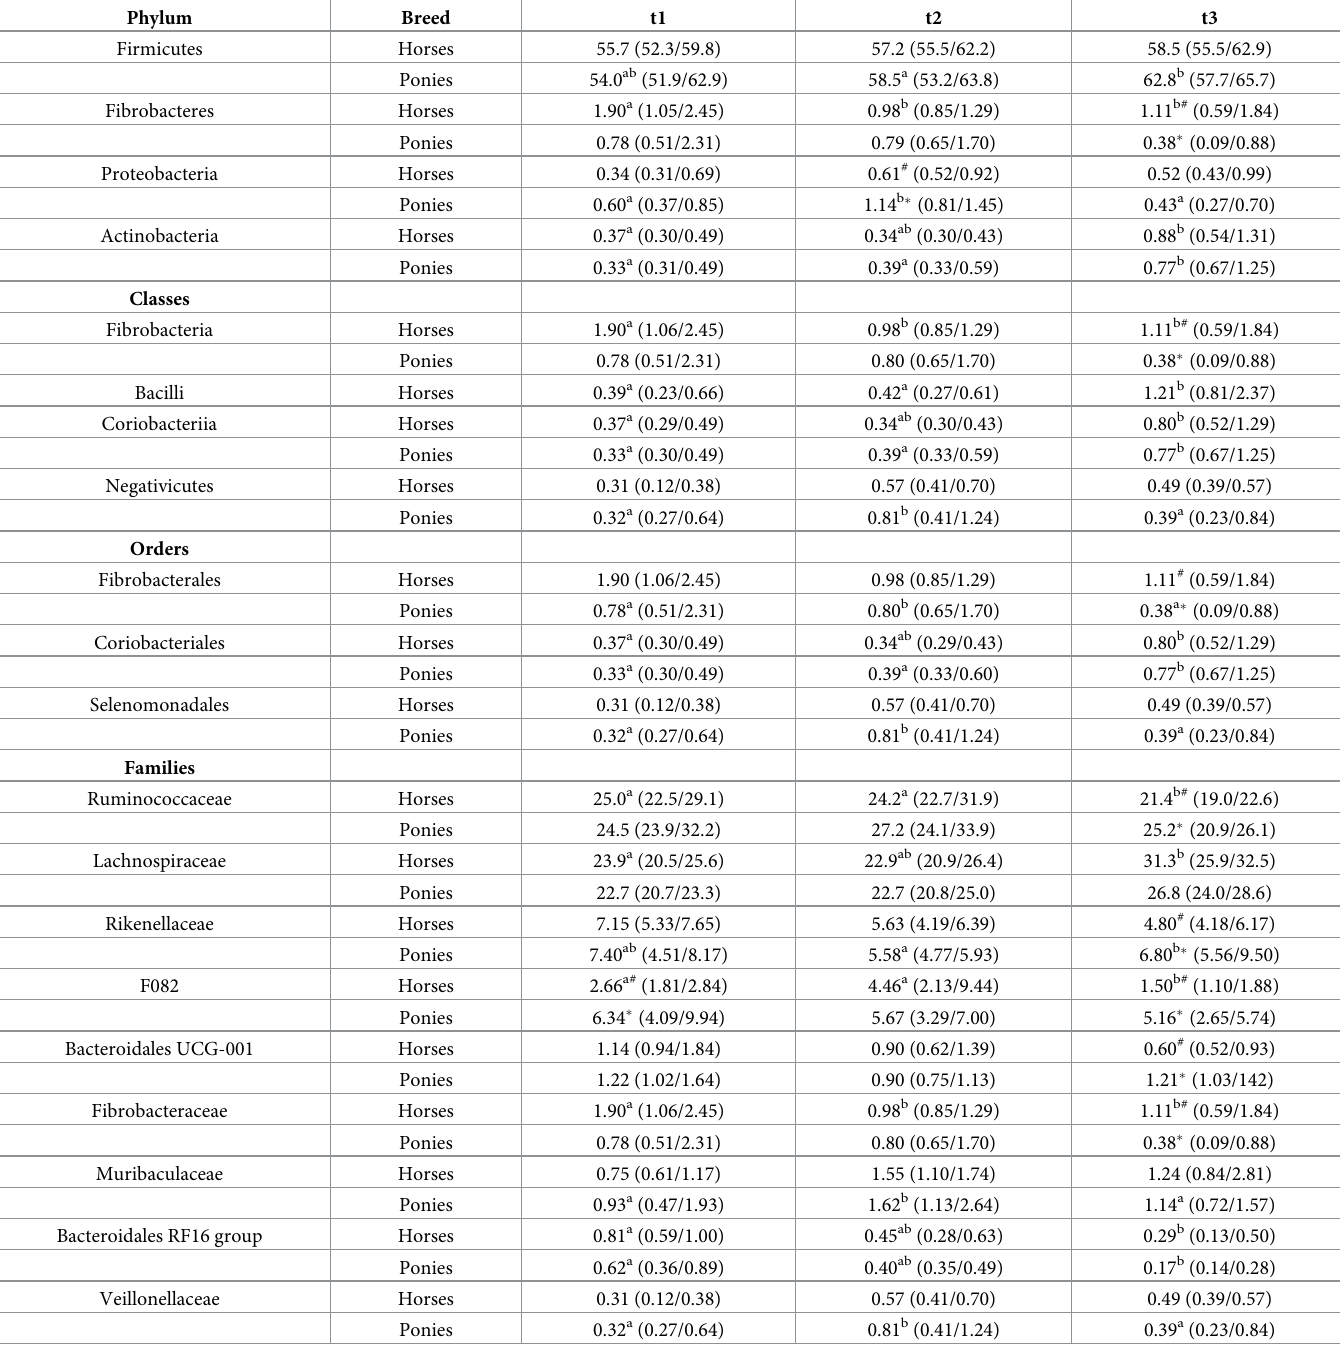
Table 3. Phyla, classes, orders and families in faeces of horses and ponies with a median relative abundance over 0.4% with significant changes between the three sampling points or between breeds. Data are presented as medians and 25/ 75 percentiles in